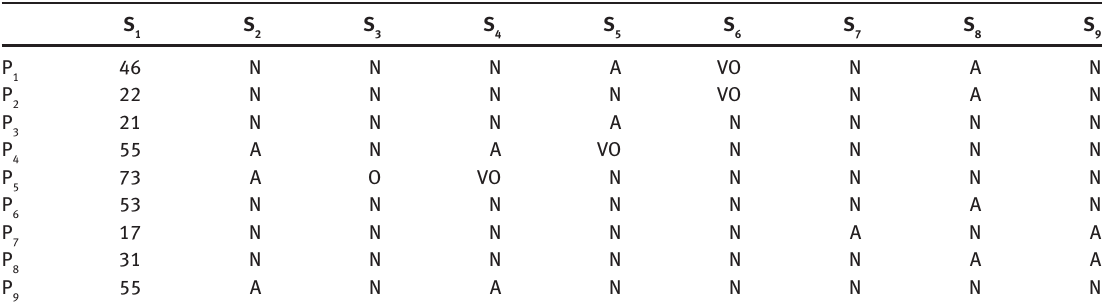
Table 6: Classification of Patients: Patient-Symptom Relation with Measurable Parameter “Age” ( S Nine Symptoms).